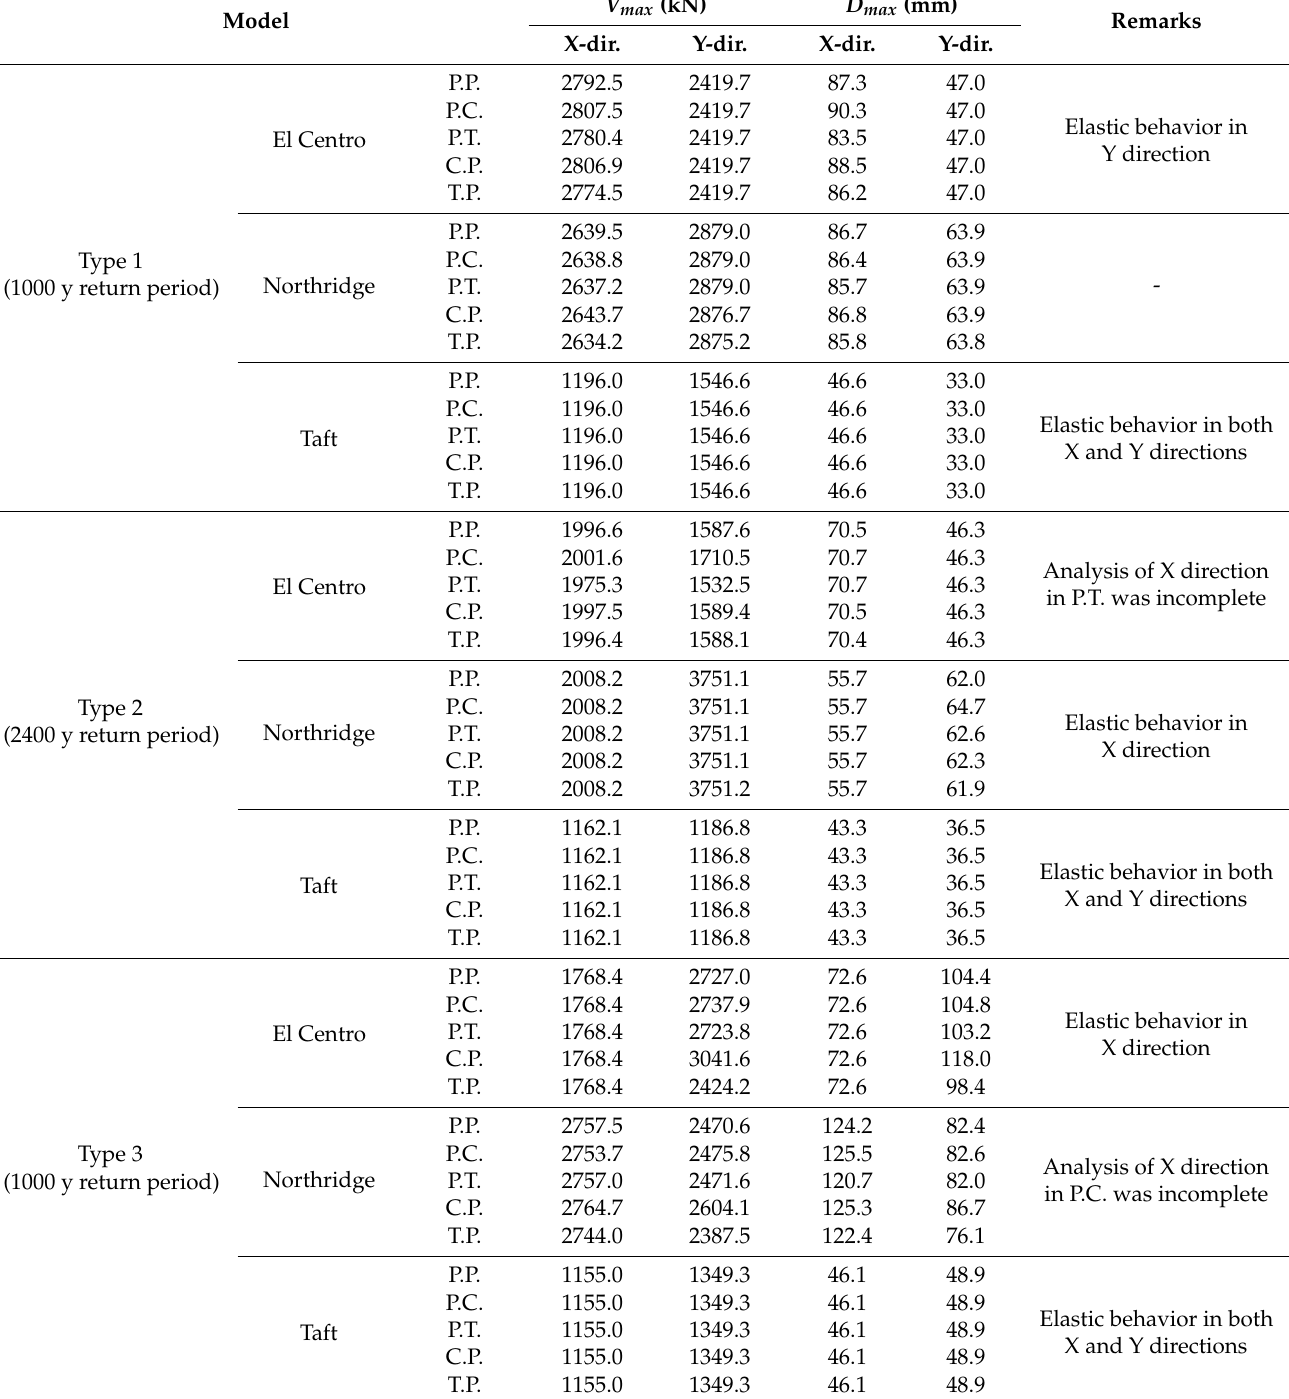
Table 4. Summary of overall responses ( V max and D max